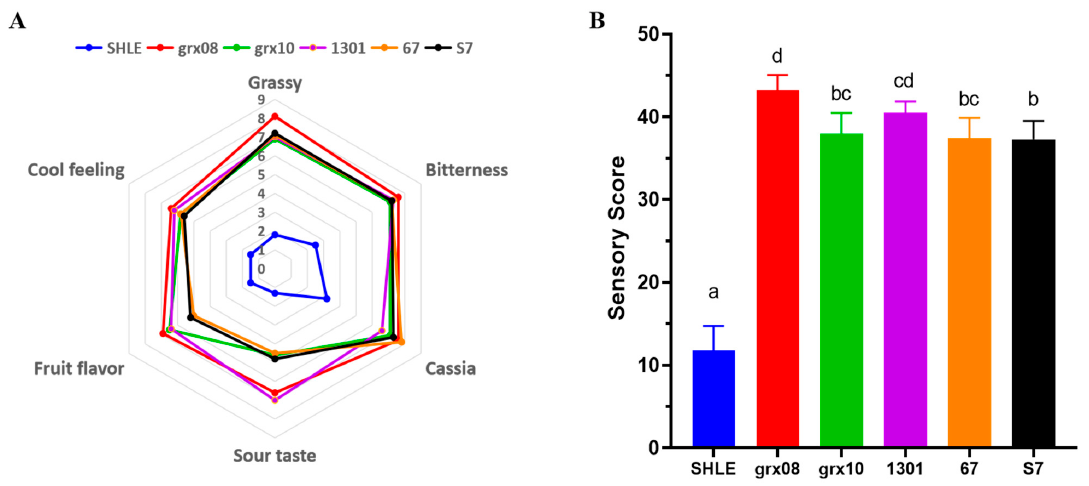
Figure 5. Effects of fermentation with different lactic acid bacteria on SHLE flavor. ( A ) Sensory scoring radar chart and ( B ) total score of sensory evaluation. Values are expressed as the mean ± standard deviation of replicate experiments ( n = 10). Different letters indicate a significant difference ( p < 0.05).